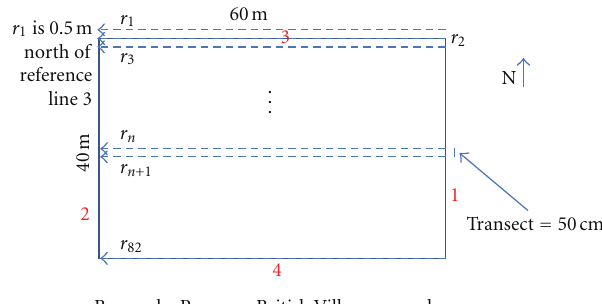
Figure 2: Brief description of survey plan of the villa site showing the position of the survey reference lines and of the first survey transect ( r 1 ).